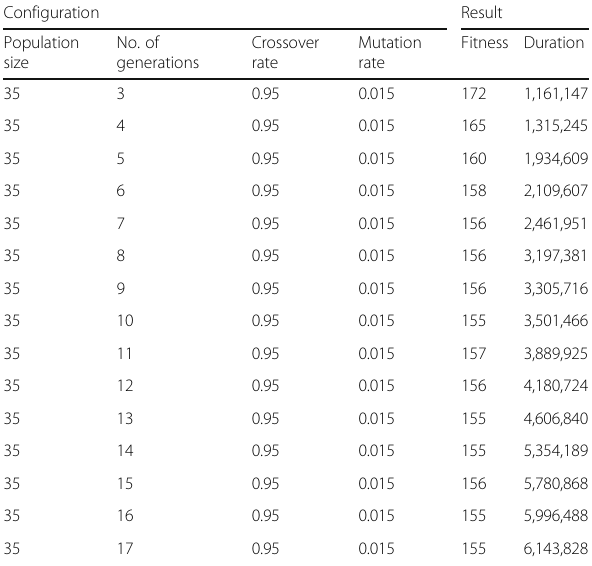
Table 14 The impact of the number of the generations on the genetic algorithm accuracy